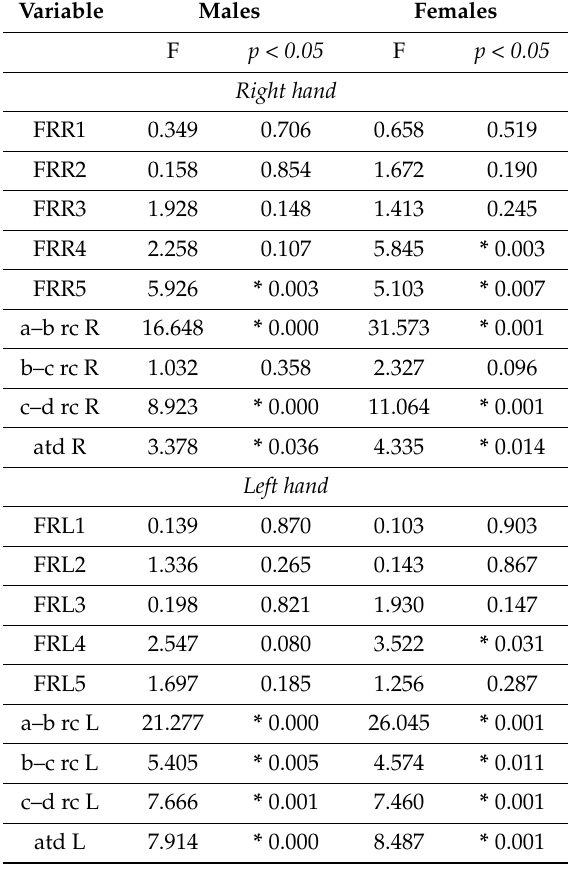
Table 1. Results of ANOVA variance analysis of quantitative dermatoglyphic traits between pituitary tumor patients (functional and non-functional) and controls. Variable Males Females F p <